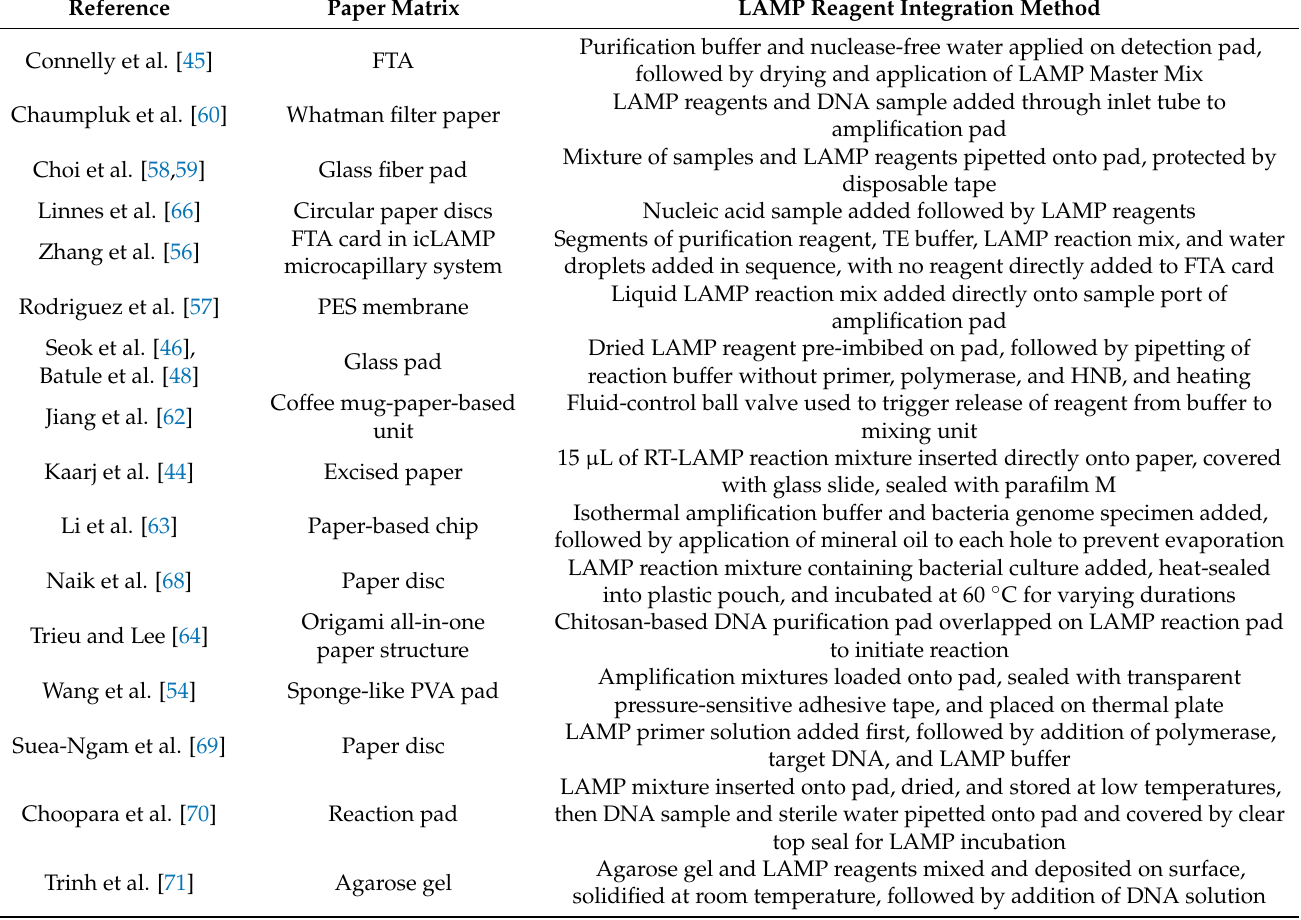
Table 1. Methods to integrate LAMP reagents on paper